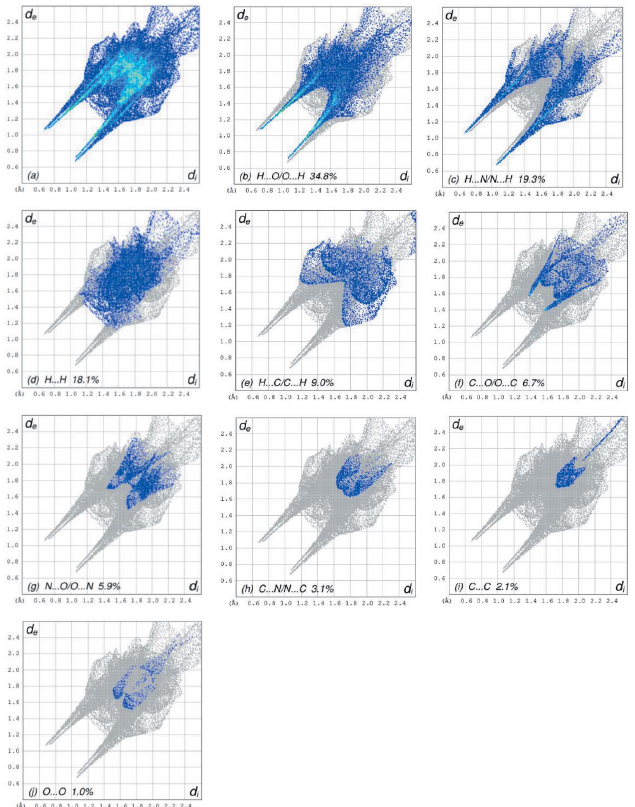
Figure 6 The full two-dimensional fingerprint plots for the title compound, showing ( a ) all interactions, and delineated into ( b ) H (cid:2)(cid:2)(cid:2) O/O (cid:2)(cid:2)(cid:2) H, ( c ) H (cid:2)(cid:2)(cid:2) N/N (cid:2)(cid:2)(cid:2) H, ( d ) H (cid:2)(cid:2)(cid:2) H, ( e ) H (cid:2)(cid:2)(cid:2) C/C (cid:2)(cid:2)(cid:2) H, ( f ) C (cid:2)(cid:2)(cid:2) O/O (cid:2)(cid:2)(cid:2) C, ( g ) N (cid:2)(cid:2)(cid:2) O/ O (cid:2)(cid:2)(cid:2) N, ( h ) C (cid:2)(cid:2)(cid:2) N/N (cid:2)(cid:2)(cid:2) C, (i) C (cid:2)(cid:2)(cid:2) C and ( j ) O (cid:2)(cid:2)(cid:2) O interactions. The d i and d